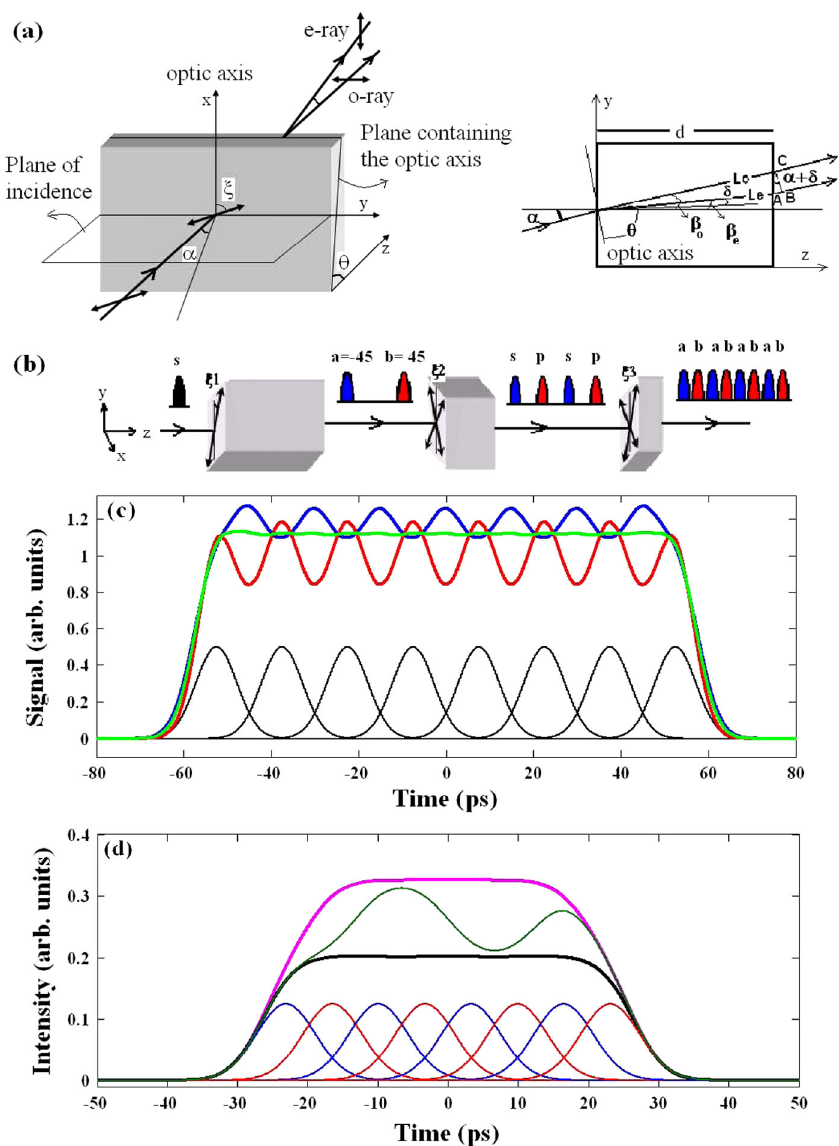
FIG. 1. (Color) (a) Left: Schematic diagram illustrating input and output pulse polarization and right: schematic diagram illustrating relevant angles, path length L o and L e for o and e rays for (cid:1) -cut birefringent crystal. (b) Schematic depicting a sequence of eight replica pulses with alternate orthogonal polarizations. The optic axis is shown by thin lines on the surface of each crystal. The polarization of the laser pulse is depicted by the double arrow shown in each crystal. The notation S, P represents s -polarization and p -polarization, respectively. Polarizations a and b depict the linear polarizations oriented at þ 45 (cid:2) , and (cid:3) 45 (cid:2) relative to the y axis of the Cartesian coordinate system. (c) Simulated temporal pulse shapes from eight replica pulses of identical polarization with zero chirp (red line), linear chirp with a spectral phase of 17 : 5 ps 2 = rad 2 (green line), and 22 ps 2 = rad 2 (blue line). All replica pulses are separated by a temporal delay of 15 ps. The intensity of eight replica pulses (scaled by half for clarity) is also depicted (black line). (d) Simulated temporal pulse and the intensity of eight replica pulses. The differential static phase between interfering pulses is set at 0 (magenta line), (cid:5)= 2 (black line), 0 and (cid:5)= 2 at alternate positions (green